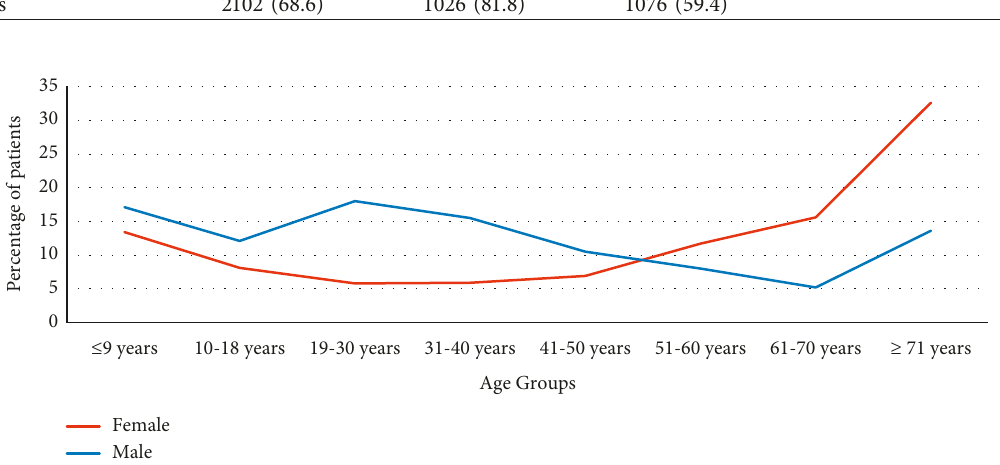
Figure 1: Comparison between males and females’ bone injury frequency across age